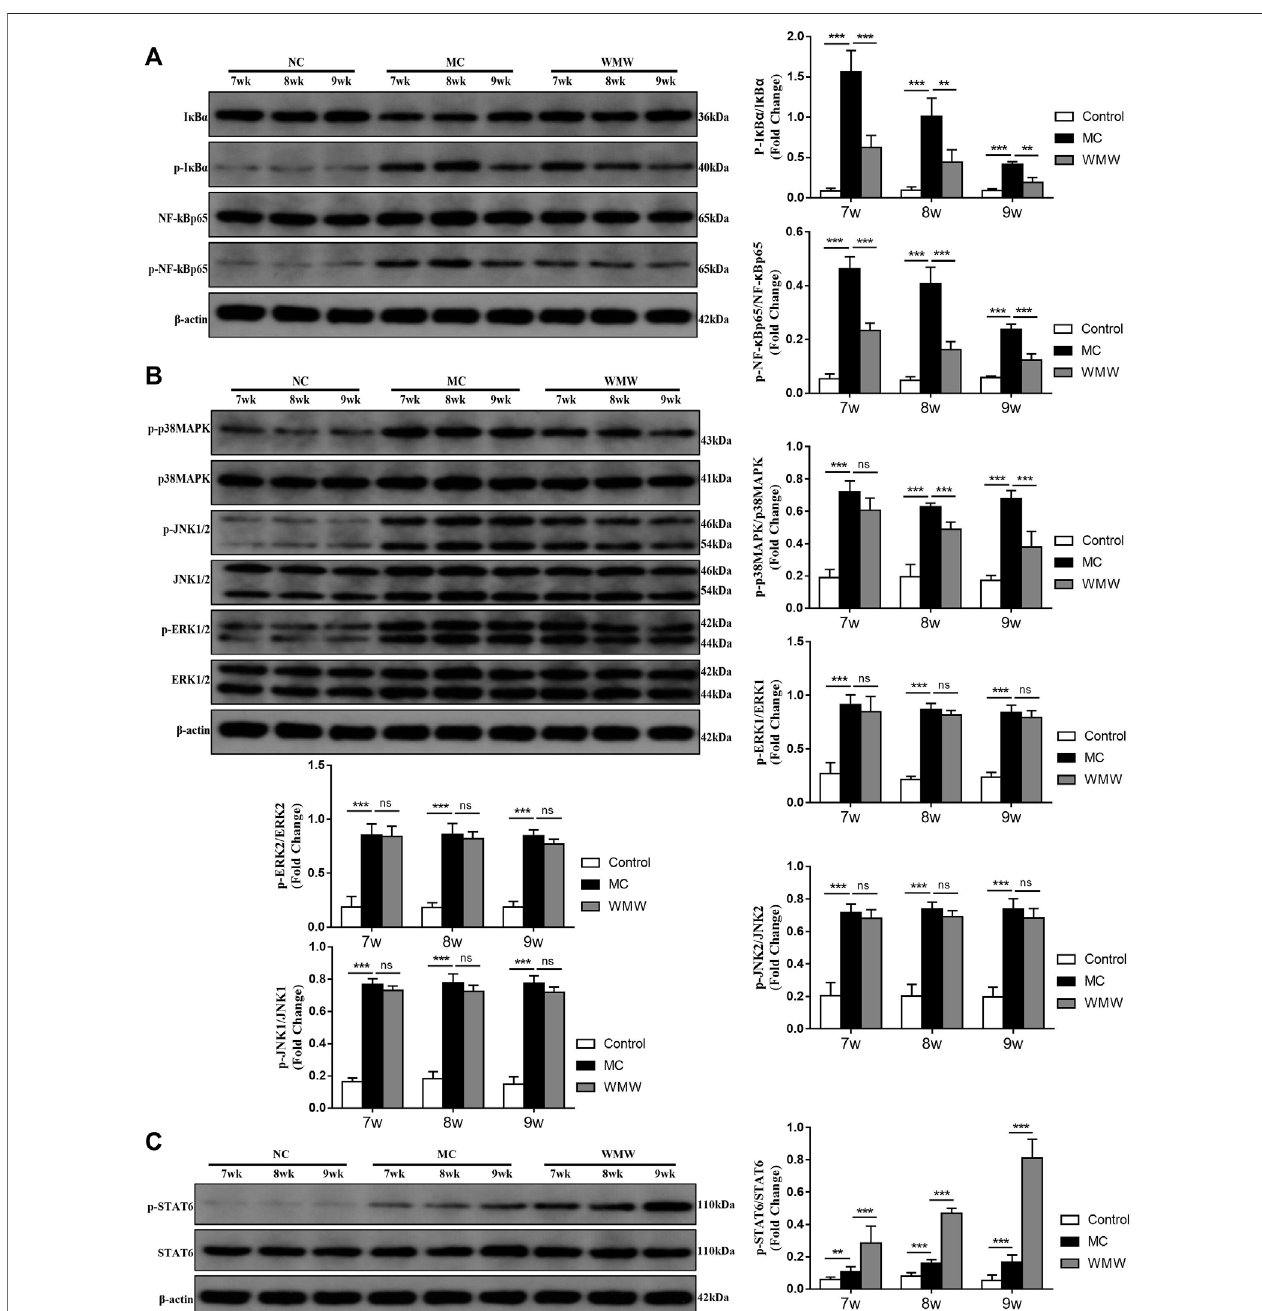
FIGURE 9 | The effects of WMW on the p38 MAPK, NF- κ B, and STAT6 signaling pathways after ulcerative colitis. (A) Expression of MAPK signaling pathway relatedproteinsP38 MAPK, ERK1/2and JNK1/2 in colon tissue lysates were determined byWesternblot from DSS-challenged mice (B) Expression of NF- κ B signaling pathwayrelatedproteinsNF- κ Bp65,I κ B α incolontissuelysatesweredeterminedbyWesternblotfromDSS-challengedmice. (C) ExpressionofSTAT6,andp-STAT6in colon tissue lysates were determined by Western blot from DSS-challenged mice. n = 3, means ± SEM.* p < 0.05, ** p < 0.01, *** p <